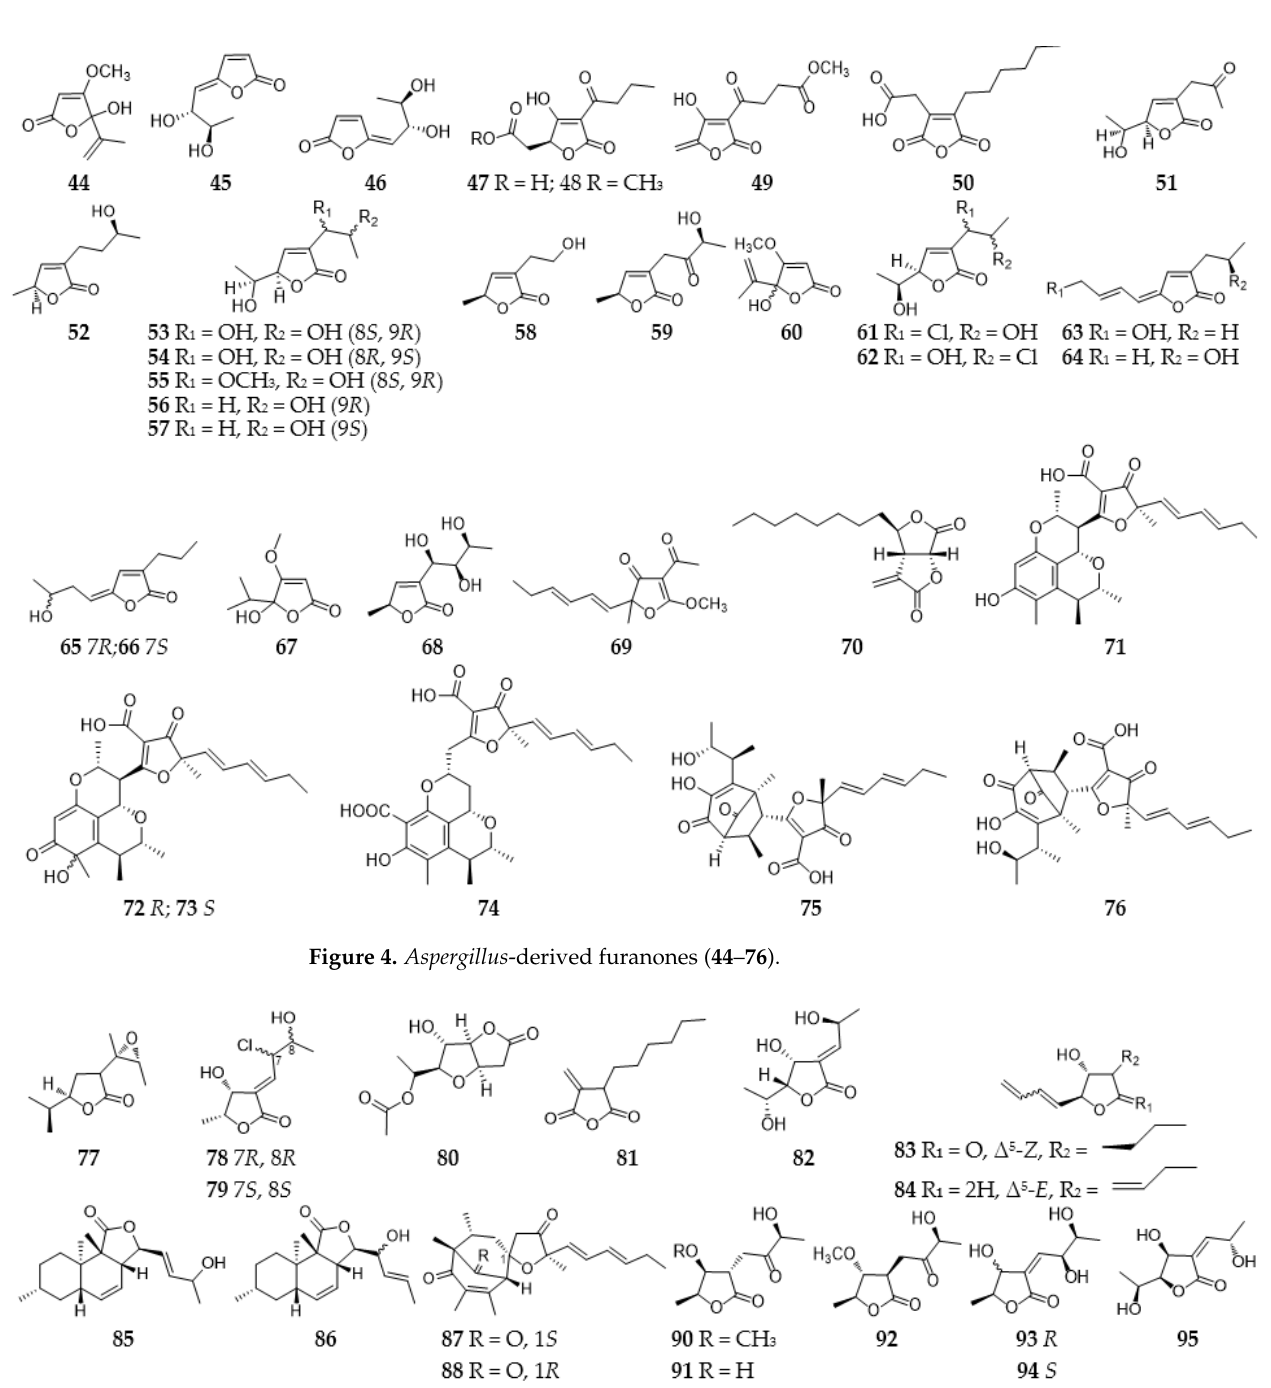
Figure 5. Aspergillus -derived tetrahydrofuranones ( 77 – 95 ).